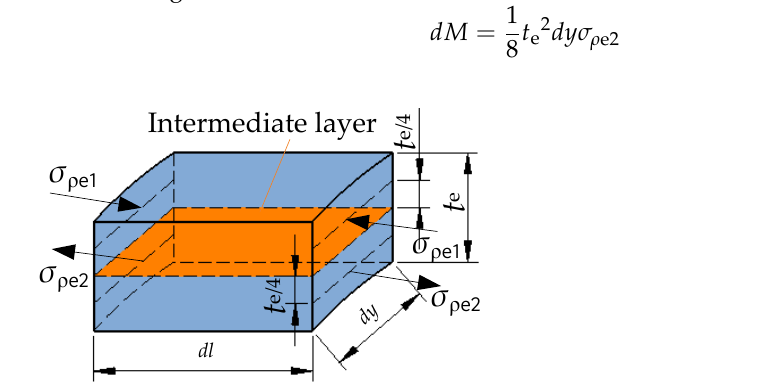
Figure 8. Element body of bending deformation area. In the bending stage, the outside metal of the intermediate layer is shortened along the axial direction and the thickness is increased, while the inside metal of the intermediate layer is elongated, and the thickness is decreased. Based on the basic assumptions and the wall thickness of the thin and thick wall side, it can be known from the Equation (4) that the axial tensile stress on the inside of the intermediate layer of the thin wall side is greater than that of the thick wall side. So, the axial deformation and thinning at the inside of the intermediate layer of the thin wall side is larger than that of the thick wall side, which results in the unevenness is increased on the inner wall of the end.